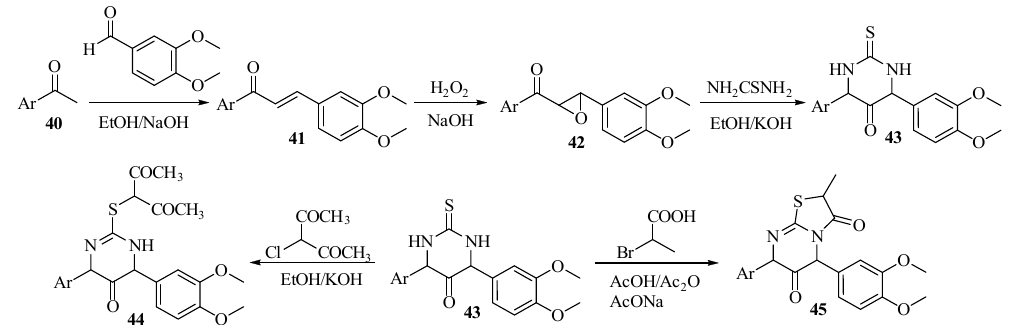
Figure 8. Comparison of effective percentages of inhibition against HSV infection among compounds 44 , 45 , and Acyclovir [42].